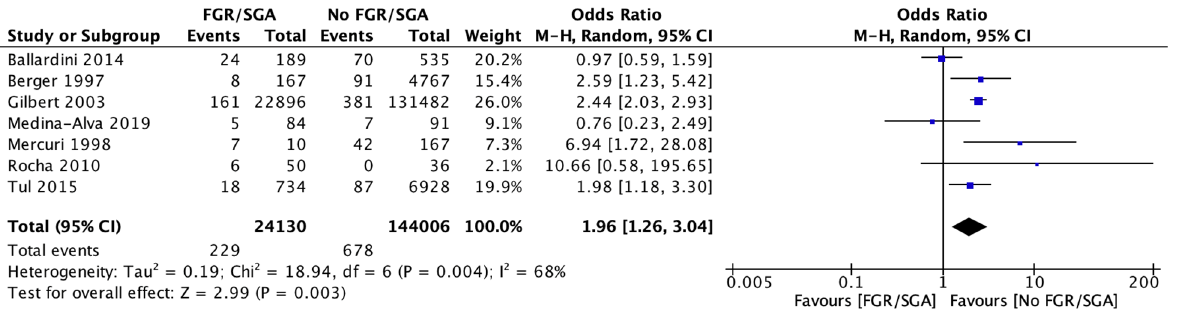
Figure 2. Forest plot comparing the risk of any cranial ultrasound abnormality among babies with fetal growth restriction compared to babies without fetal growth restriction among all infants more than 32 weeks.